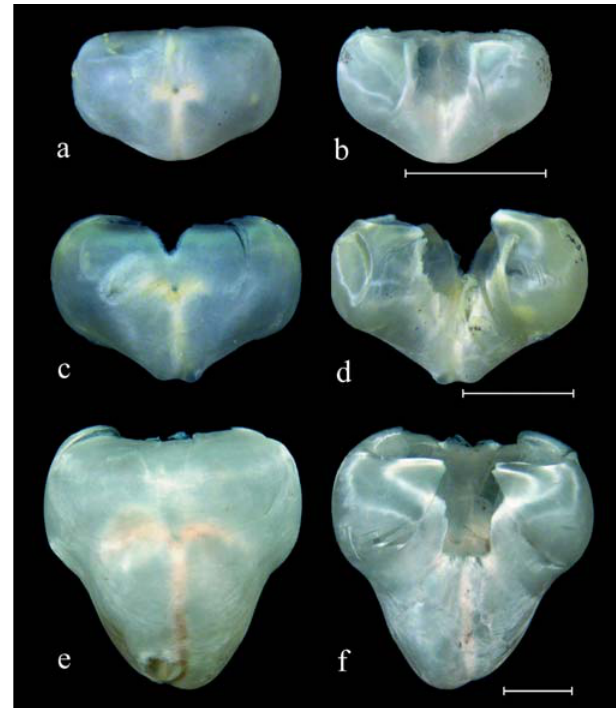
Fig. 5. Gas bladder of Leptodoras oyakawai , MZUSP 87028, 54 mm SL in (a) ventral and (b) dorsal views; MZUSP 95722, 88 mm SL in (c) ventral and (d) dorsal views; MZUSP 97395, 121.9 mm SL in (e) ventral and (f) dorsal views. Scale bar 5